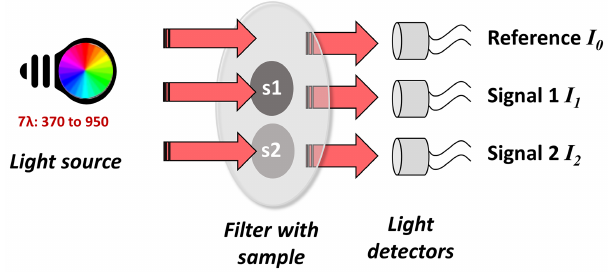
Figure 1. Schematic representation of the optical chamber in the Aethalometer